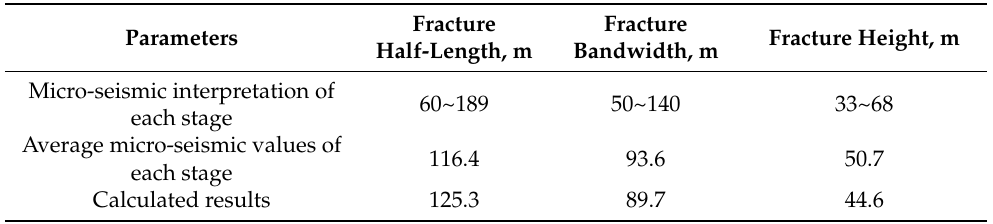
Table 4. Comparison of hydraulic fracture geometry.